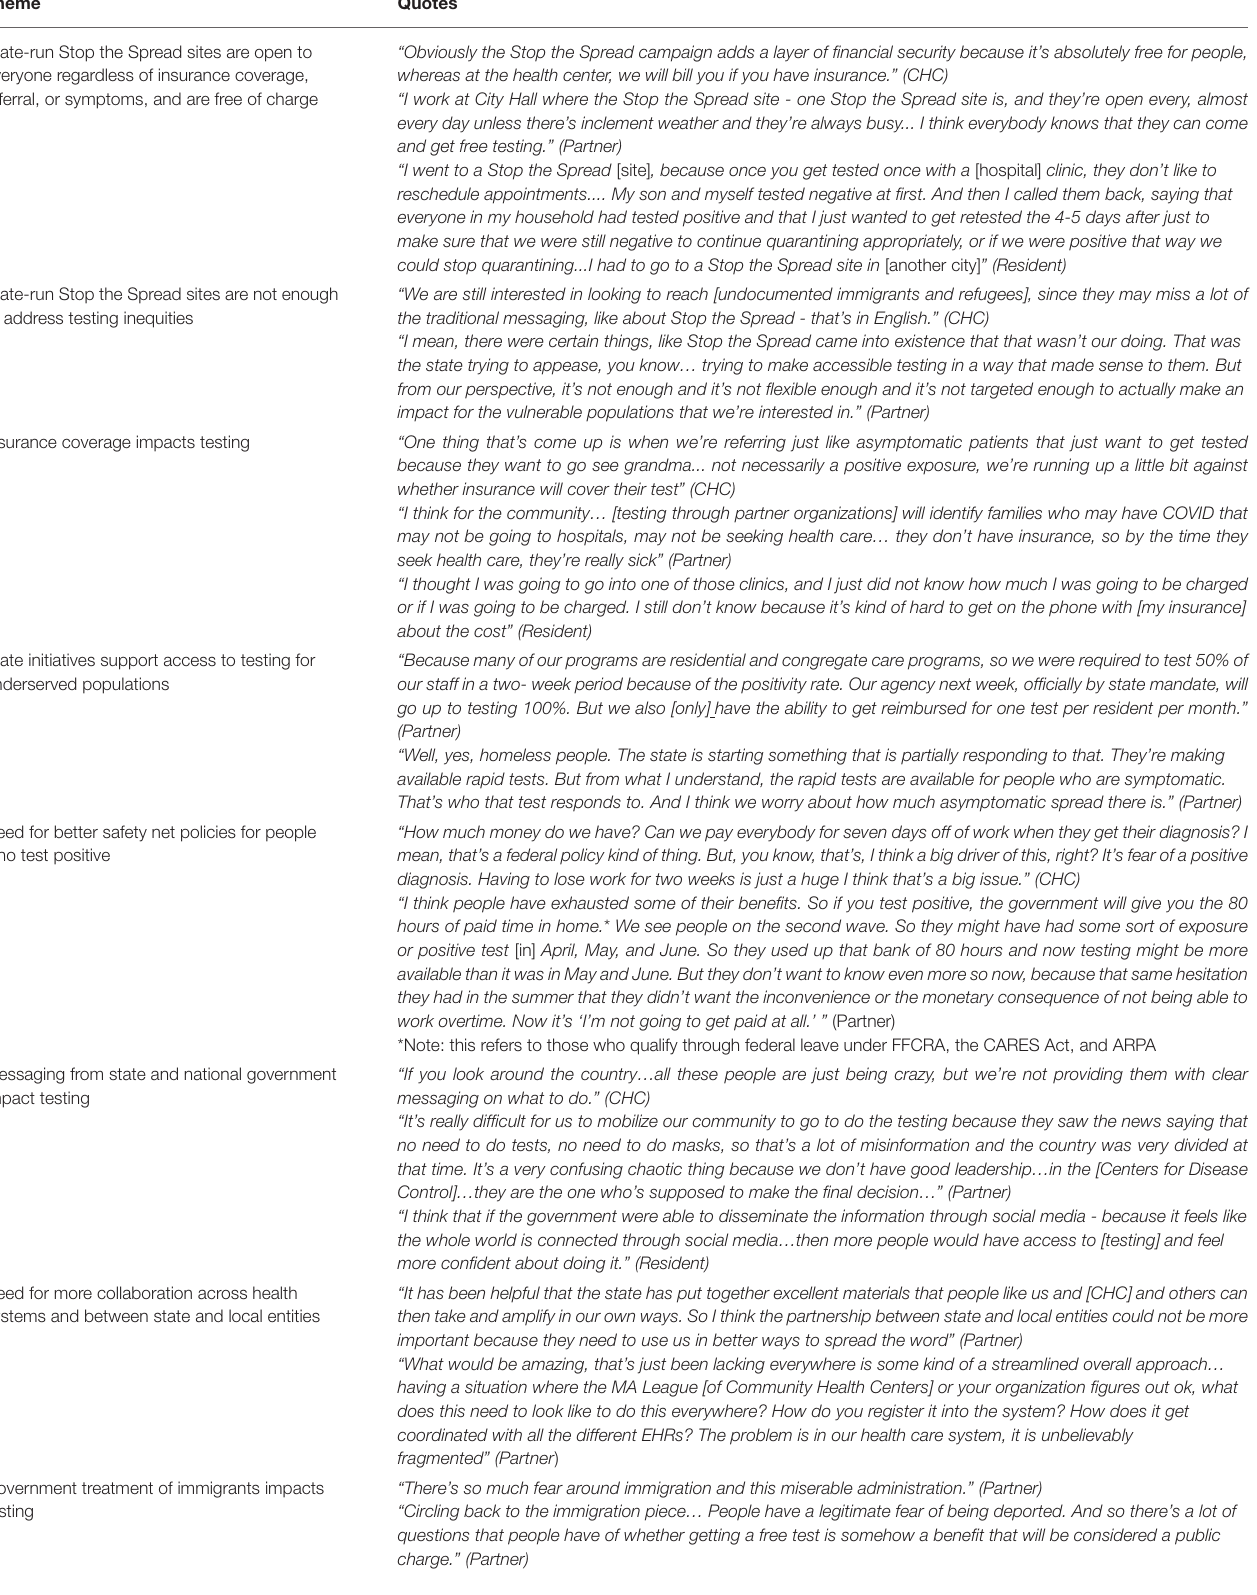
Theme Quotes State-run Stop the Spread sites are open to everyone regardless of insurance coverage, referral, or symptoms, and are free of